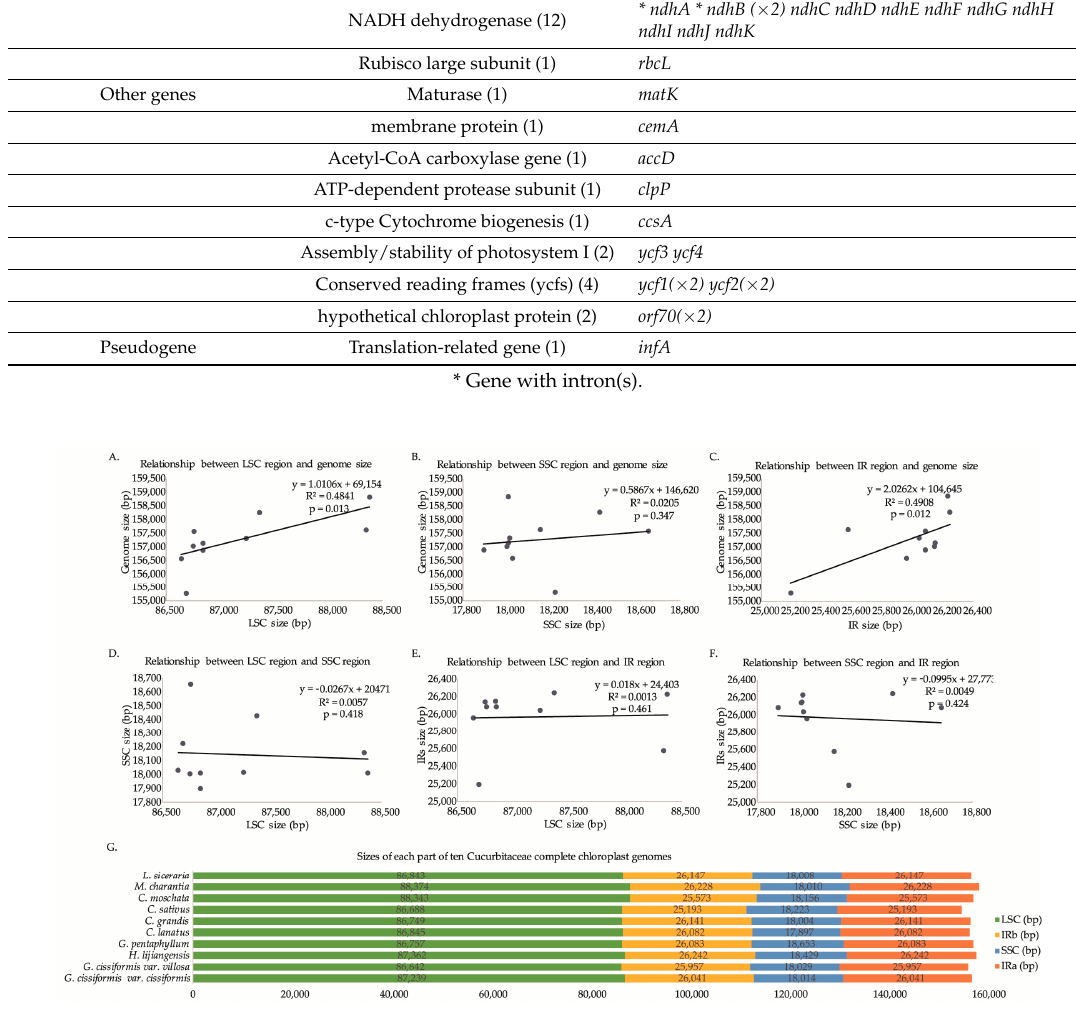
Figure 2. Relationships between complete chloroplast genome sizes and LSC, SSC and IR regions lengths, respectively. ( A – F ) Correlational relationships among each region; ( G ) sizes of each part of ten Cucurbitaceae complete chloroplast genomes.